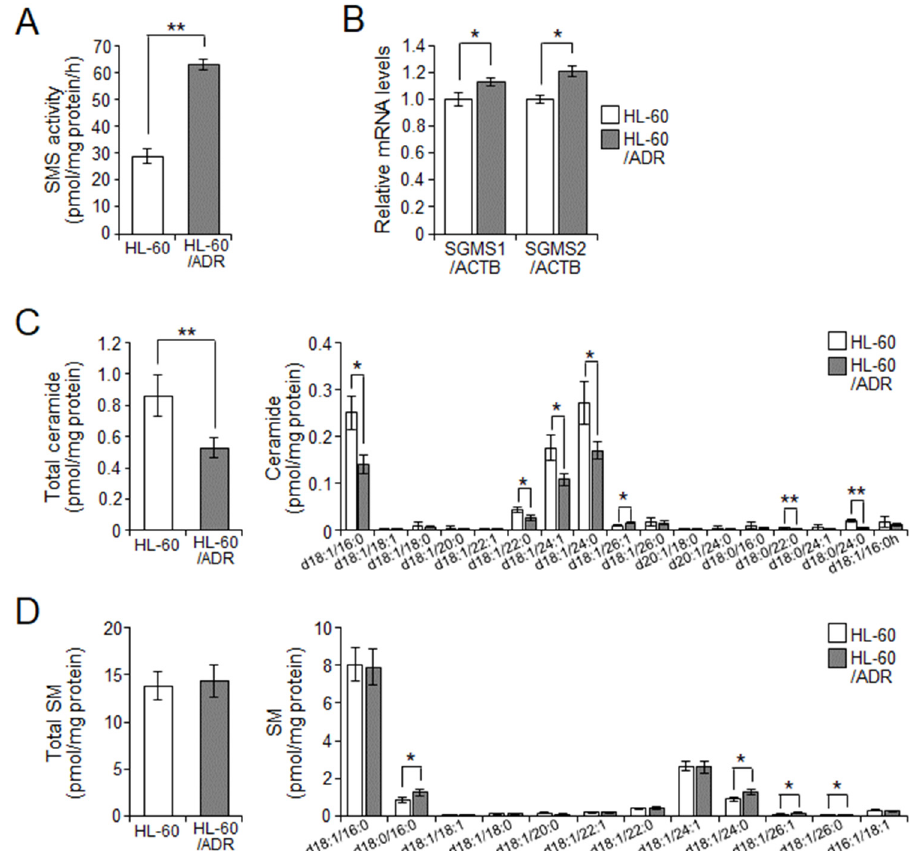
Figure 3. SMS regulates intracellular ceramide levels in HL-60/ADR cells. ( A ) Cellular SMS activity was analyzed using C 6 -NBD-ceramide as the substrate. ( B ) qPCR analysis of SGMS1 (SMS1) and SGMS2 (SMS2) in HL-60 and HL-60/ADR cells. Expression of SMSs was normalized against ACTB expression. ( C , D ) Sphingomyelin (SM) ( C ) and ceramide ( D ) levels were measured by LC-MS/MS. Values indicate mean ± SD ( n = 3). * p < 0.05, ** p < 0.005.